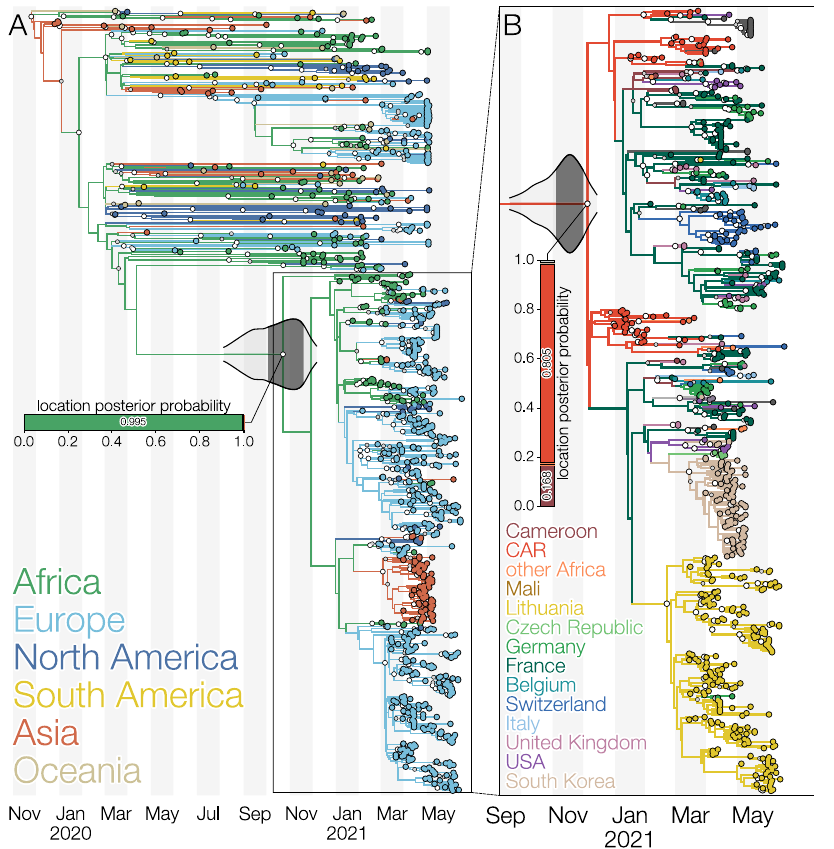
Fig. 4 Maximum clade credibility trees of lineage B.1.620 coloured by reconstructed location using the latest available data as of June 2021. A Global phylogeny of SARS-CoV-2 genomes with branches coloured by inferred continent from a Bayesian phylogeographic analysis that makes use of individual travel histories. Lineage B.1.620 is outlined and a horizontal bar shows the posterior probability of its common ancestor existing in a given continent. Africa is reconstructed as the most likely location (posterior probability 0.995) where B.1.620 originated. The 95% and 50% highest posterior density (HPD) intervals for the most recent common ancestor date of lineage B.1.620 are indicated with violin plots centred on the common ancestor. B Phylogeny of lineage B.1.620 with branches coloured by inferred country from a Bayesian phylogeographic analysis that makes use of travel histories. A vertical bar shows posterior probabilities of where the common ancestor of B.1.620 existed. In this analysis, Central African Republic (CAR) and Cameroon are reconstructed as the most likely locations (with posterior probabilities of 0.805 and 0.168, respectively) of the common ancestor of lineage B.1.620. Larger white dots at nodes indicate nodes with a posterior probability of at least 95%, while smaller grey circles indicate nodes with a posterior probability of at least 50%. The 95% and 50% highest posterior density (HPD) intervals for the most recent common ancestor date of lineage B.1.620 are indicated with violin plots centred on the common